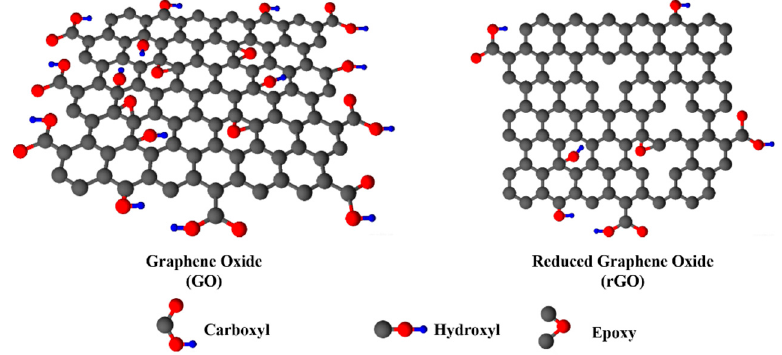
Figure 2. Depictions of GO and rGO structures.